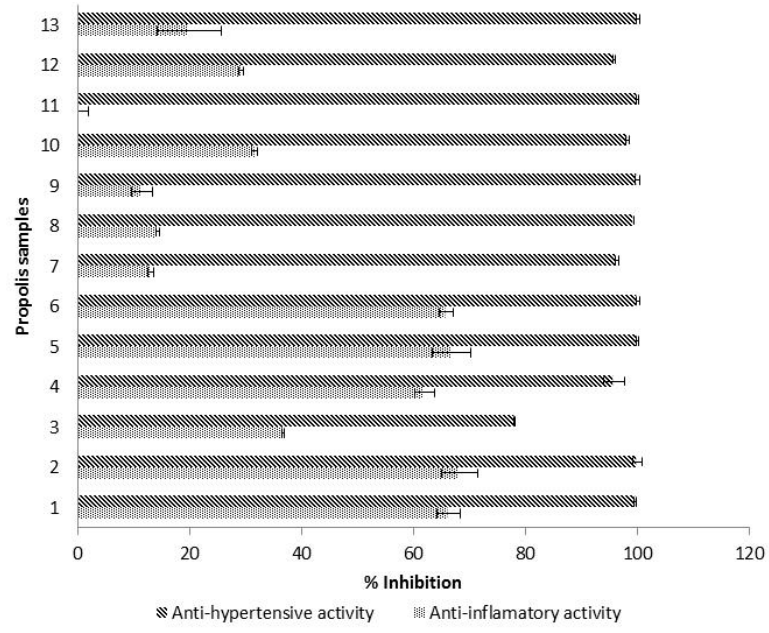
Figure 3. Mean values ( n = 3) of hyaluronidase inhibitory activity and ACE inhibitory activity, expressed as % of inhibition. Error bars represent the standard deviation for each data point.